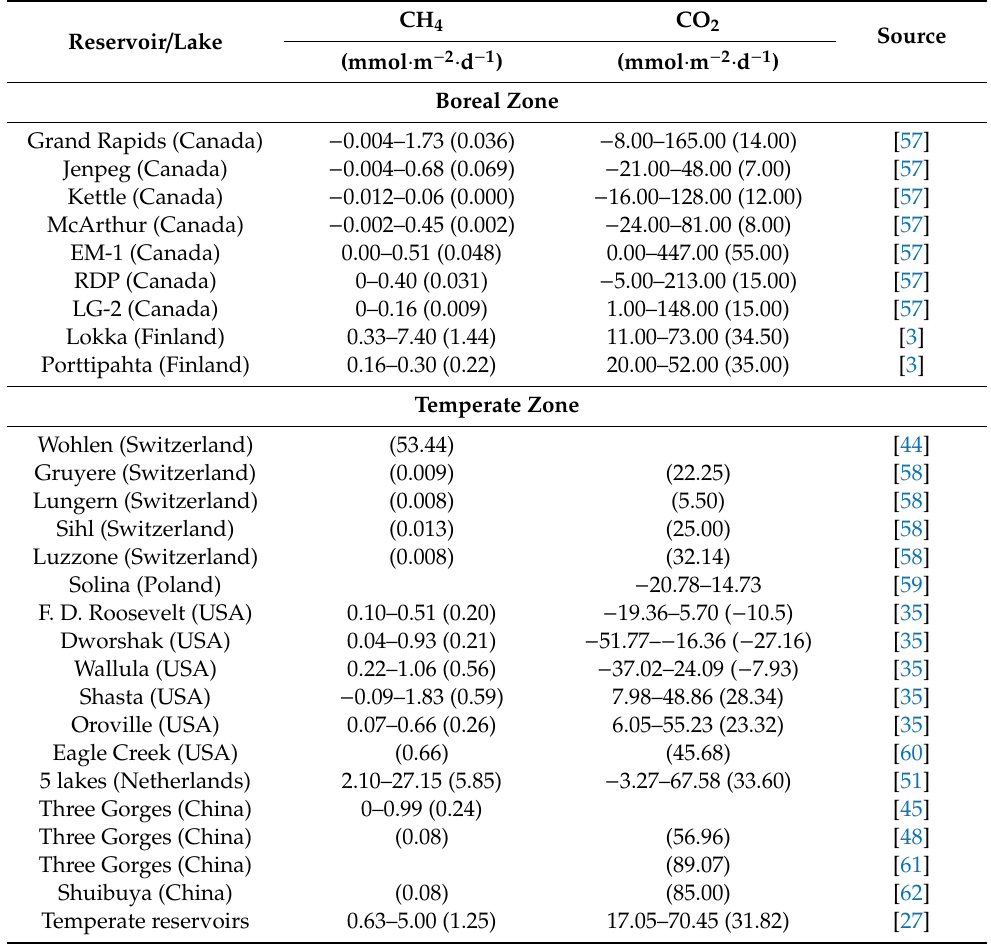
Table 3. Review of CH 4 and CO 2 fluxes from boreal and temperate reservoir / lakes; mean values are given in